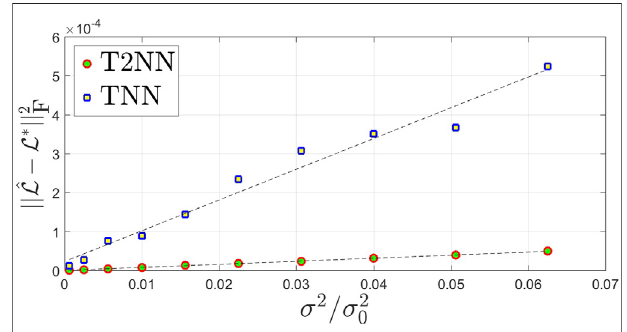
FIGURE2| Estimationerrorvs.the(squared)noiselevel σ 2 / σ 2 0 fortensor compressed sensing of underlying tensors of size 16×16×16 and rank proxy r =2. The proposed T2NN is compared with TNN [37].